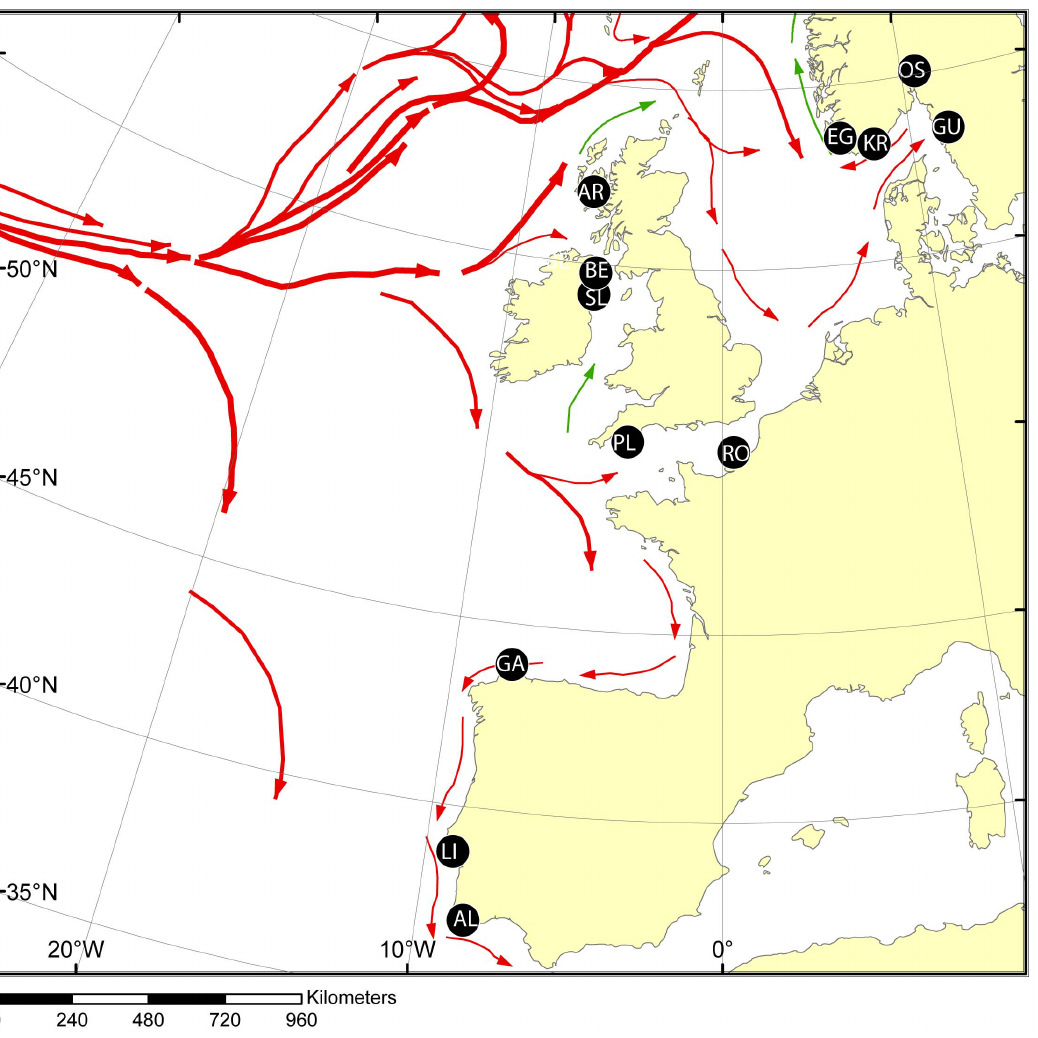
Figure 2. Map identifying sample locations (black circles: see Table 1 for sample abbreviations and details). Red arrows denote the predominant surface currents relevant for the pelagic (larvae) face of the cork wing wrasse.